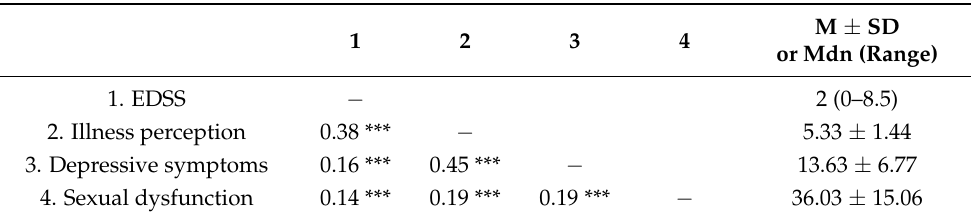
Table 1. Spearman’s correlations between disease severity, illness perception, depressive symptoms, and sexual dysfunction.